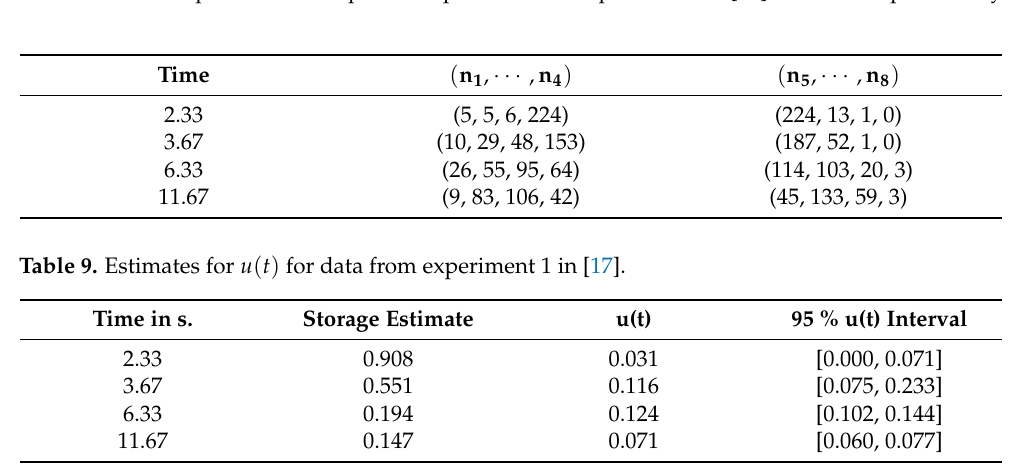
Table 8. The table provides the response frequencies from experiment 1 in [17] for each temporal delay.